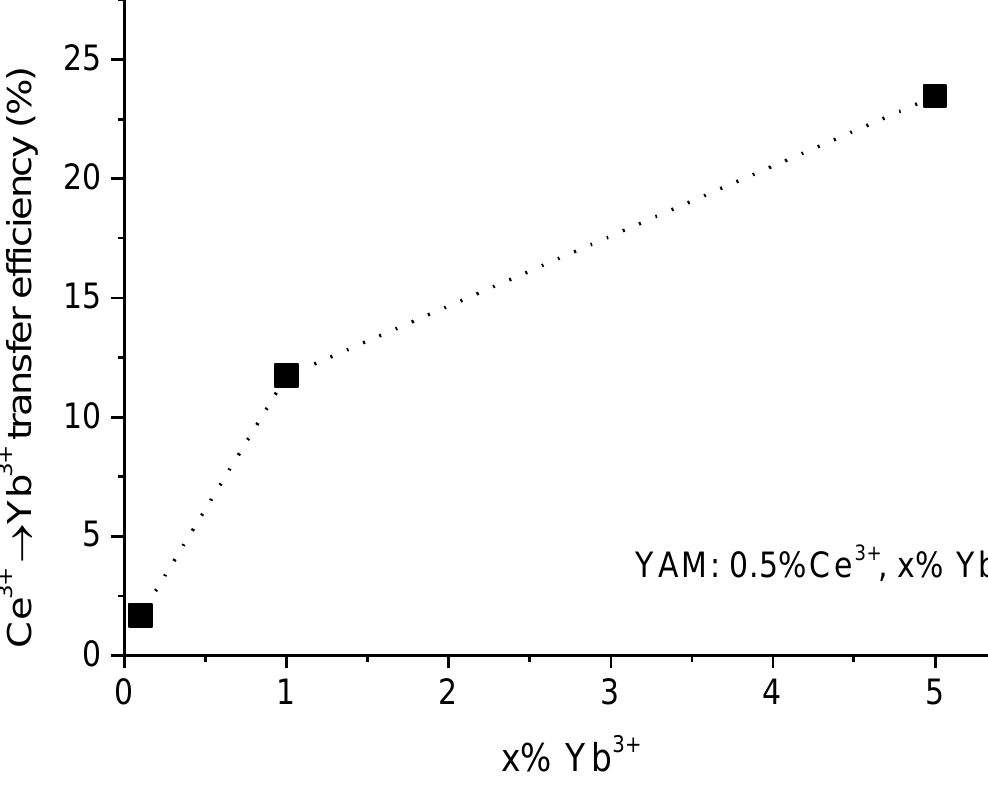
Figure 9. Calculated Ce 3+ → Yb 3+ energy transfer efficiency.